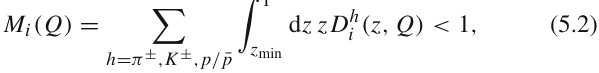
Table 4 Summary of the various choices for the small- z kinematic cuts for each hadronic species that are investigated here. For experiments taken √ √ s = M Z ( s < M Z ), data points with z < z ( M Z ) at